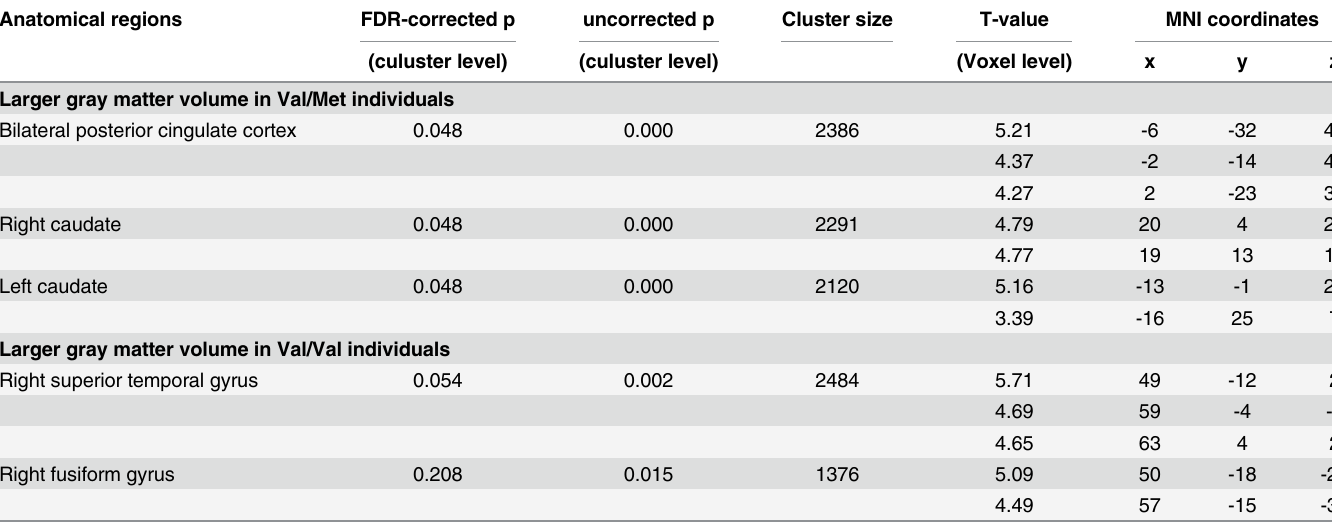
Table 2. Results of Voxel-based morphometry analysis. Anatomical regions